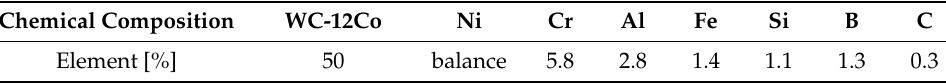
Table 1. Chemical composition of Metco 439 NS powder.